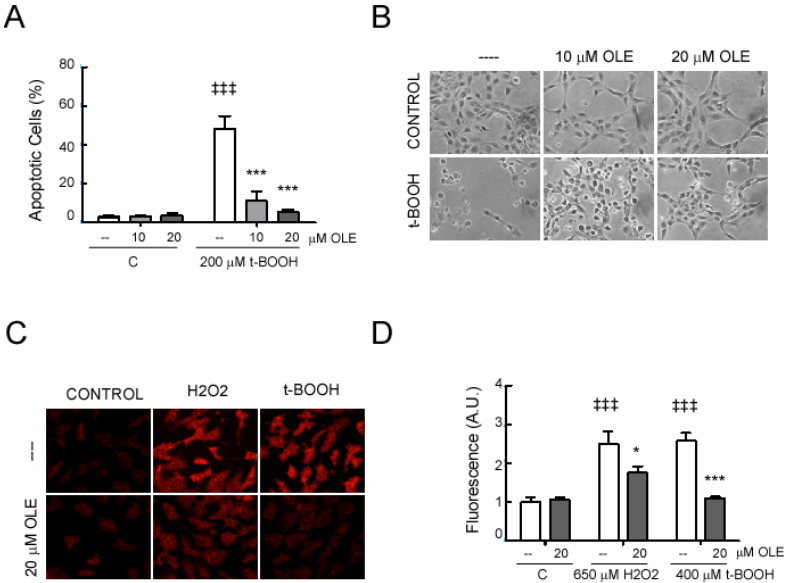
Figure 7. Oleacein treatment modulates RGC-5 activation. RGC-5 cells were pretreated for 30 min with the indicated doses of OLE. ( A ) Cell apoptosis was assayed after 24 h of incubation in the absence or presence of 200 μM of tert-butyl hydroperoxide (t-BOOH). . Apoptotic cells were estimated by